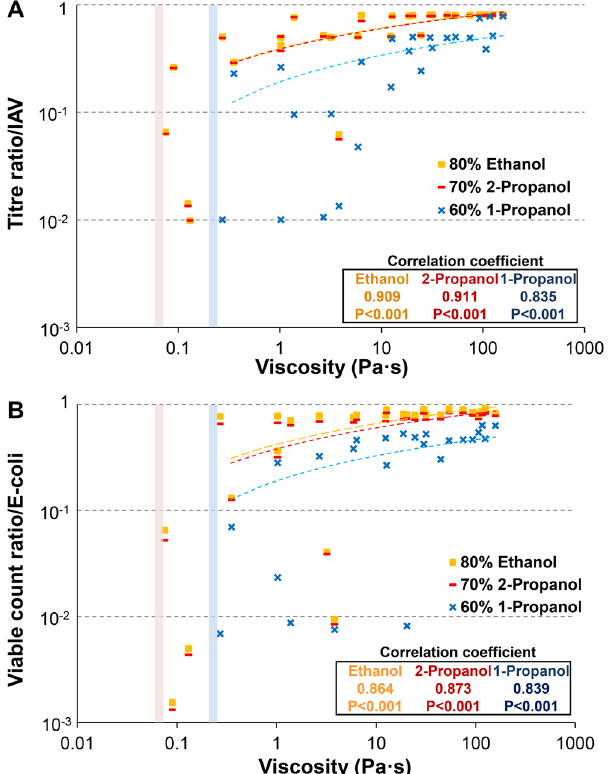
Figure 3. Viscosity and titre/viable count ratio are positively correlated. Scatter plot of viscosity of all types of artificial mucus vs. titre/viable count ratio; correlations were determined with Pearson’s correlation coefficient. ( A ) Pearson’s correlation coefficient between a viscosity and the titre ratio of IAV. ( B ) Pearson’s correlation coefficient between viscosity and viable count ratio of E . coli . The threshold of viscosity was